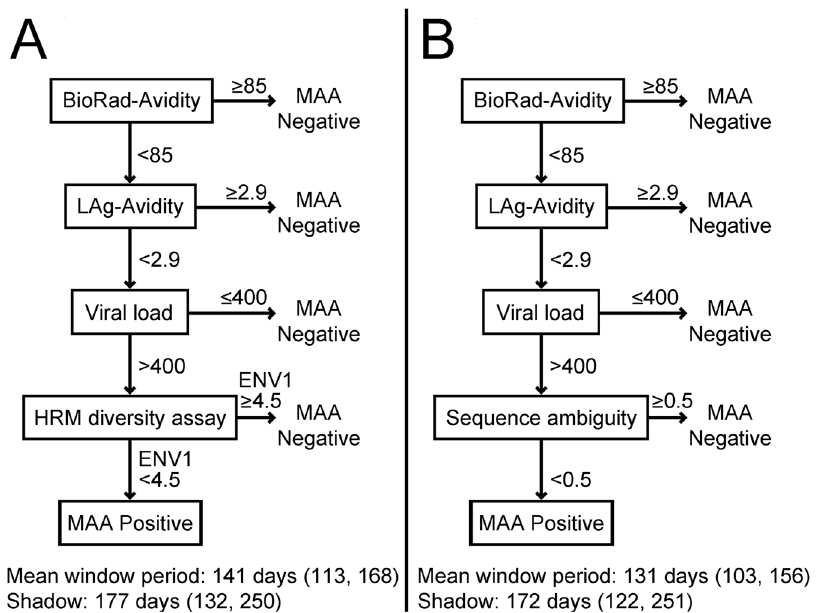
Figure 1. Multi-assay algorithms (MAAs) for cross-sectional HIV incidence estimation. Two MAAs are shown. The mean window period and shadow for each MAA are shown; 95% confidence intervals are shown in parentheses. Results from the component assays were expressed as follows: BioRad-Avidity assay: percentage (avidity index); limiting antigen avidity enzyme immunoassay (LAg-Avidity): normalized optical density units (OD-n); viral load: copies/mL; high resolution melting (HRM) diversity assay: single number (HRM score); sequence ambiguity: percentage.